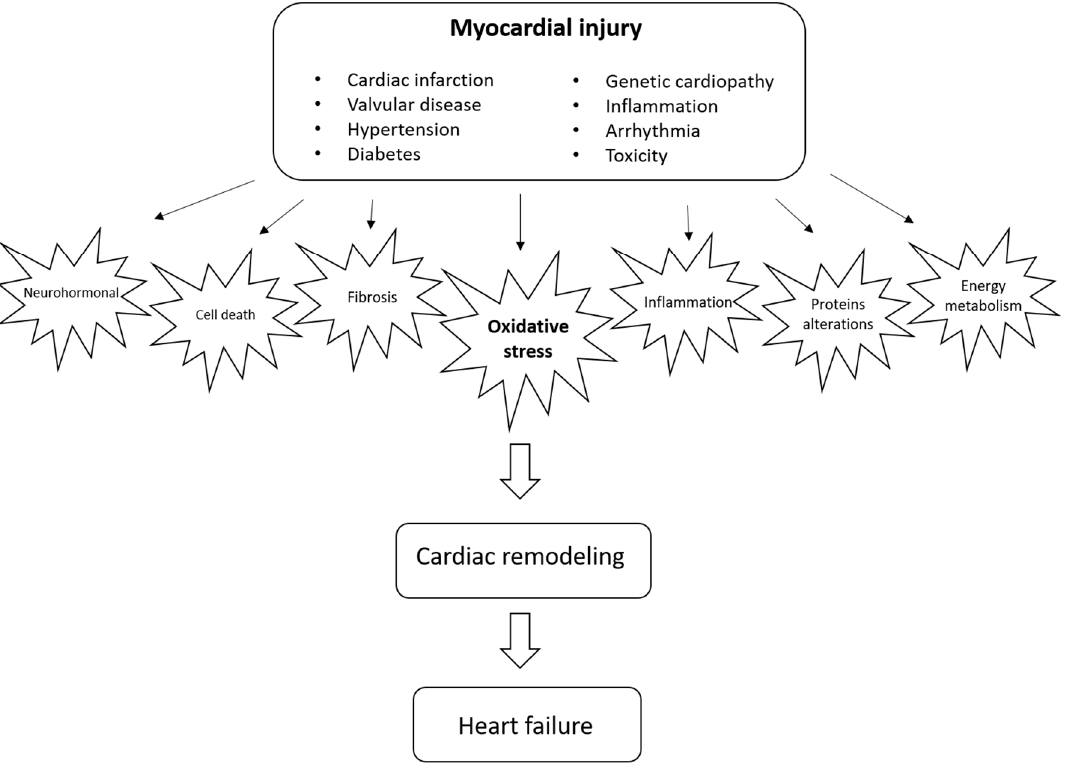
Figure 1. Natural history of cardiac